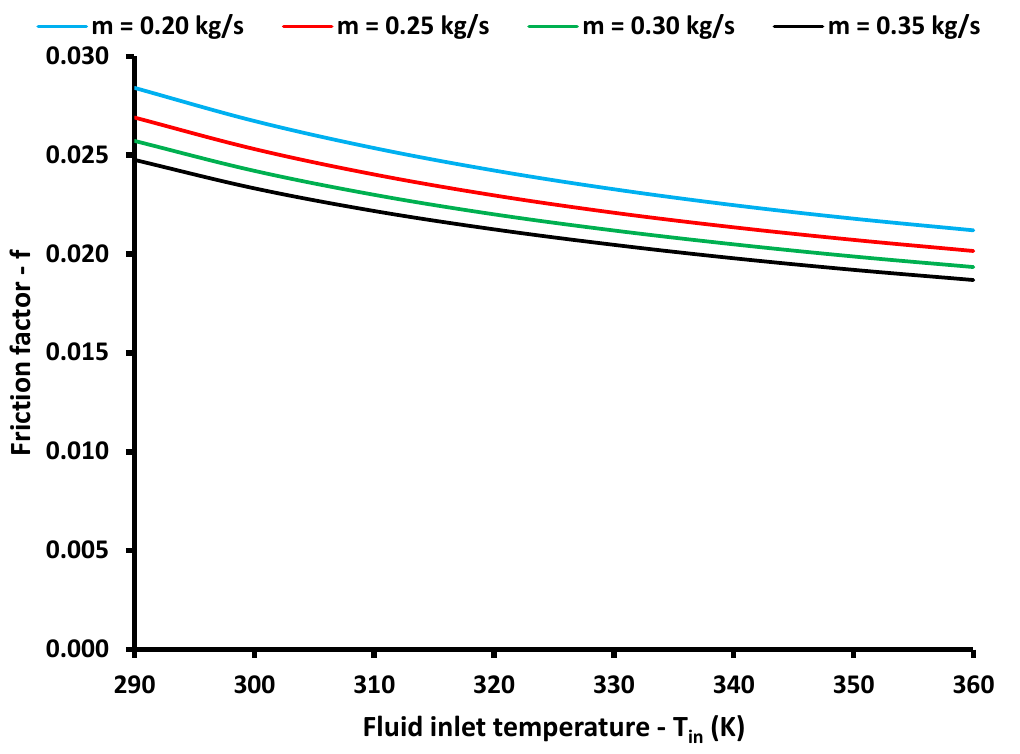
Figure 8. Heat transfer coefficient variation for the different operating scenarios in the reference case of the empty tube.